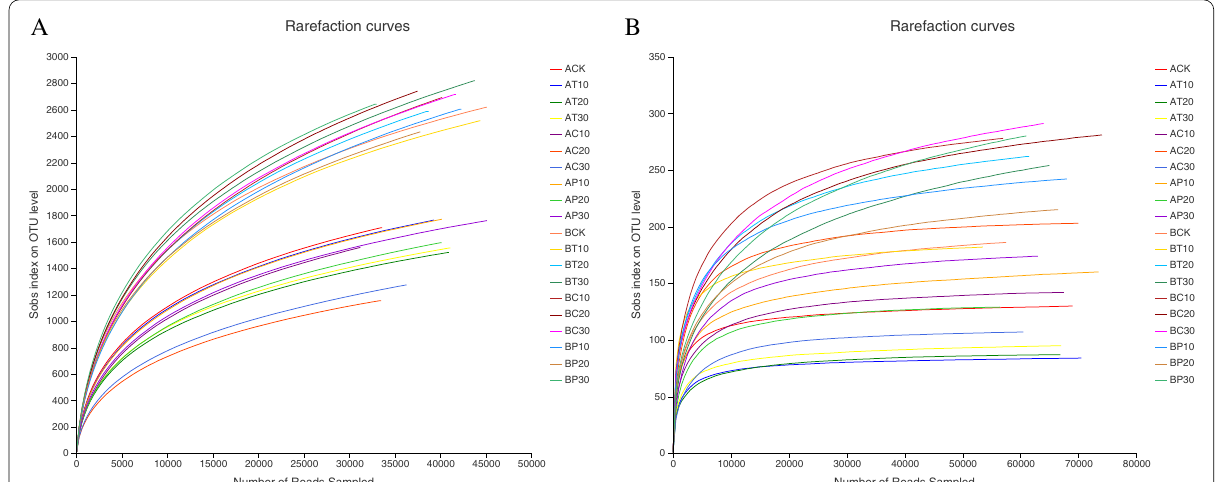
Fig. 1 Rarefaction curves of different vegetable residues application. A Rarefaction curves of bacterial communities. B Rarefaction curves of fungal